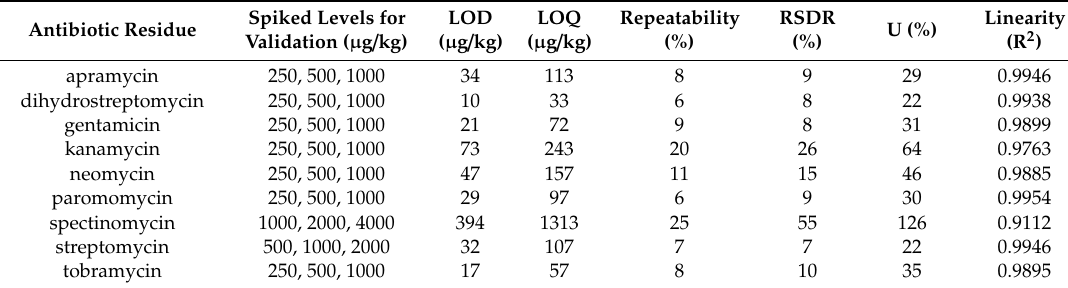
Table 9. Overview of the used concentrations during the validation, limit of detection (LOD), limit of quantification (LOQ), intralaboratory reproducibility (RSDR), expanded measurement uncertainty (U), mean linearity (R 2 ) for the selected aminoglycosides in pig manure at the di ff erent validation levels. Spiked Levels for LOD LOQ Antibiotic Residue Validation ( µ g / kg) ( µ g / kg) ( µ g /